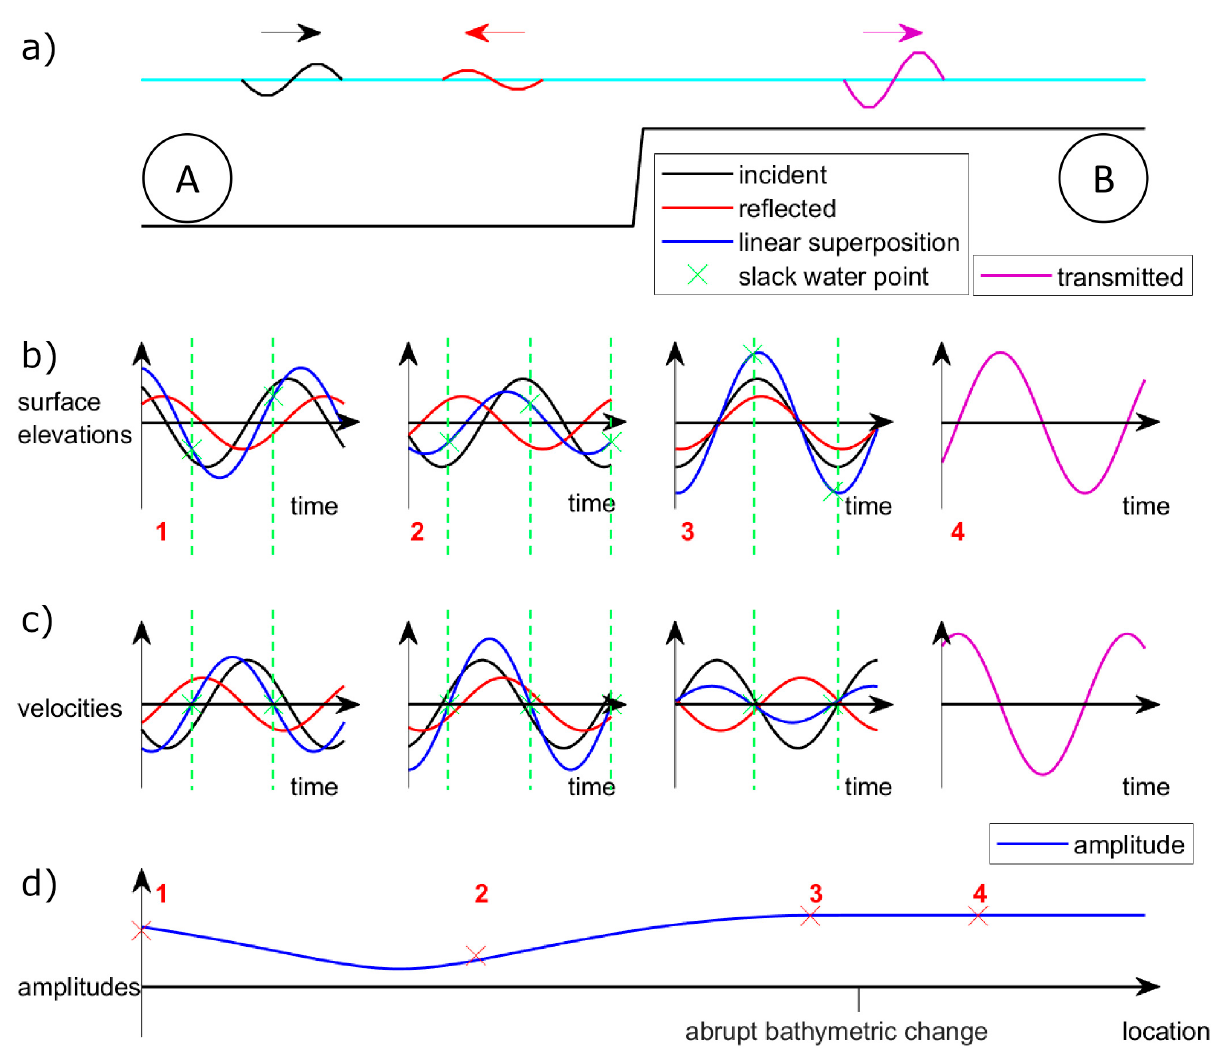
Figure 1. Simplified representation of the reflection and transmission of a tidal wave at an abrupt bathymetric change. In ( a ) the incident, reflected, and transmitted waves at an abrupt bathymetric change are shown with the corresponding surface elevations ( b ) and flow velocities ( c ) at three different locations downstream in the abrupt bathymetric change (area A) and one location upstream in the abrupt bathymetric change (area B). In ( d ) the amplitude of the overall signal (partial standing wave) is shown.